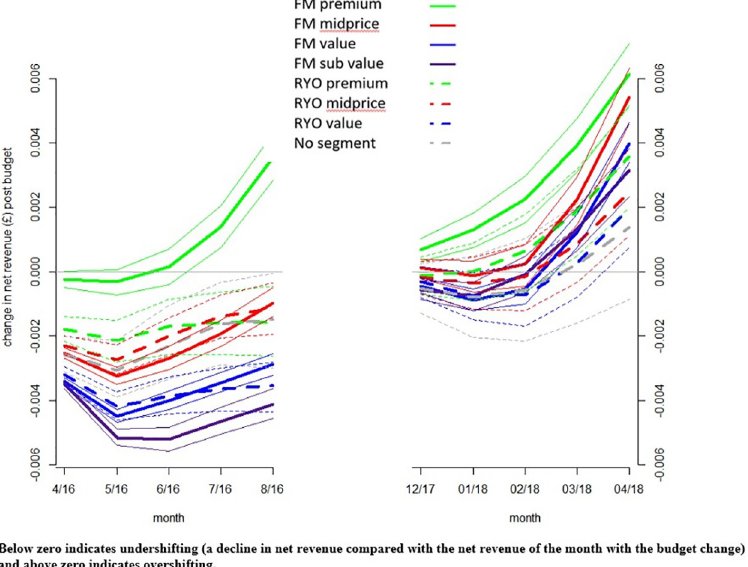
Fig 5. Mean change in weighted average net revenue (& 95% CI) of market segments during five months after (a) the pre implementation tax change (March 2016) and (b) the post full implementation tax change (November